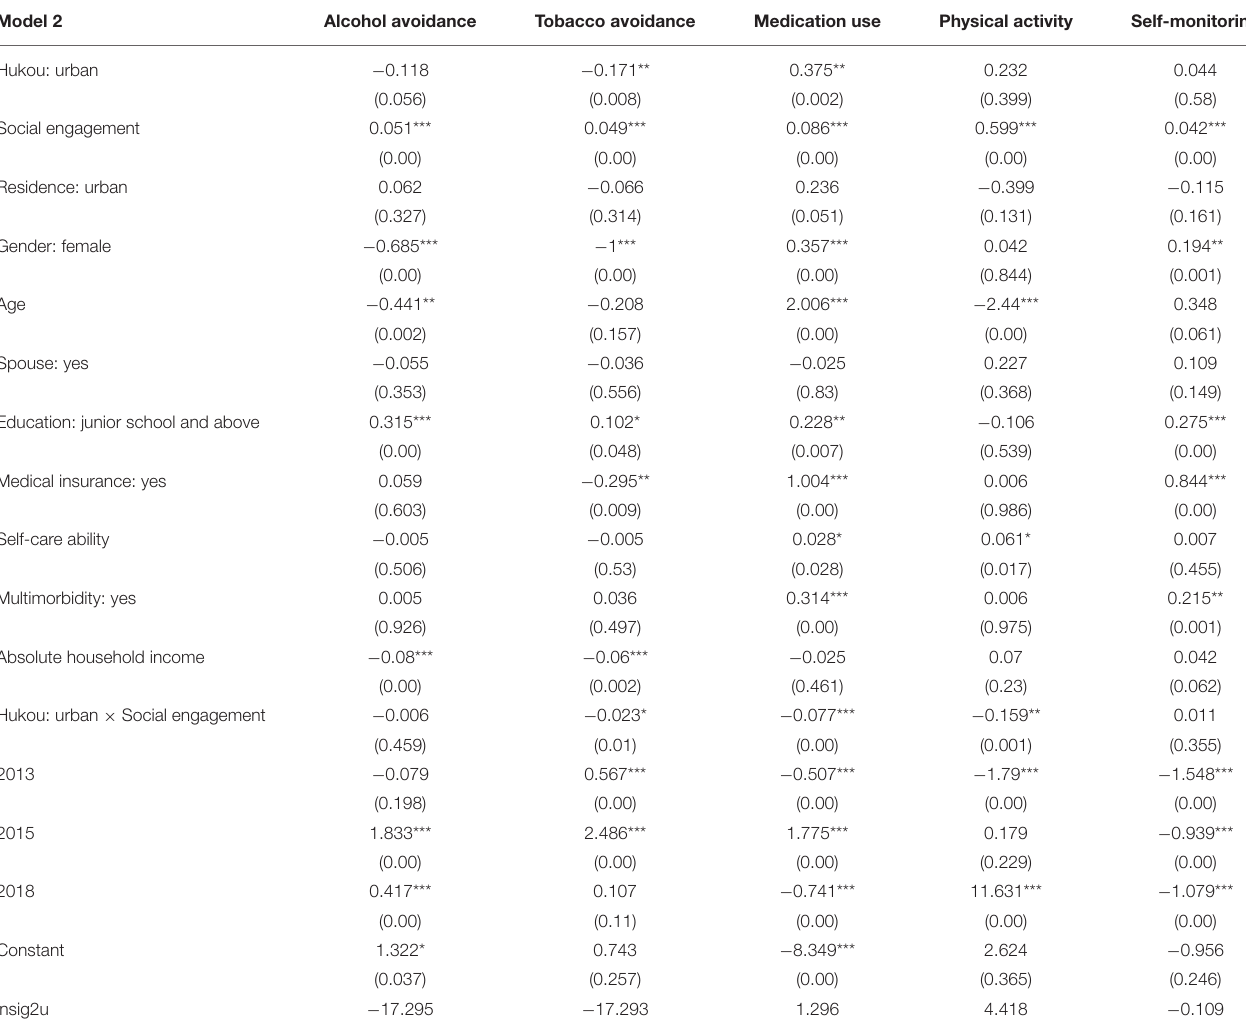
TABLE 4 | Random-effect panel logit regressions reporting the effect of social engagement on urban-rural disparities of self-management behaviors. Model 2 Alcohol